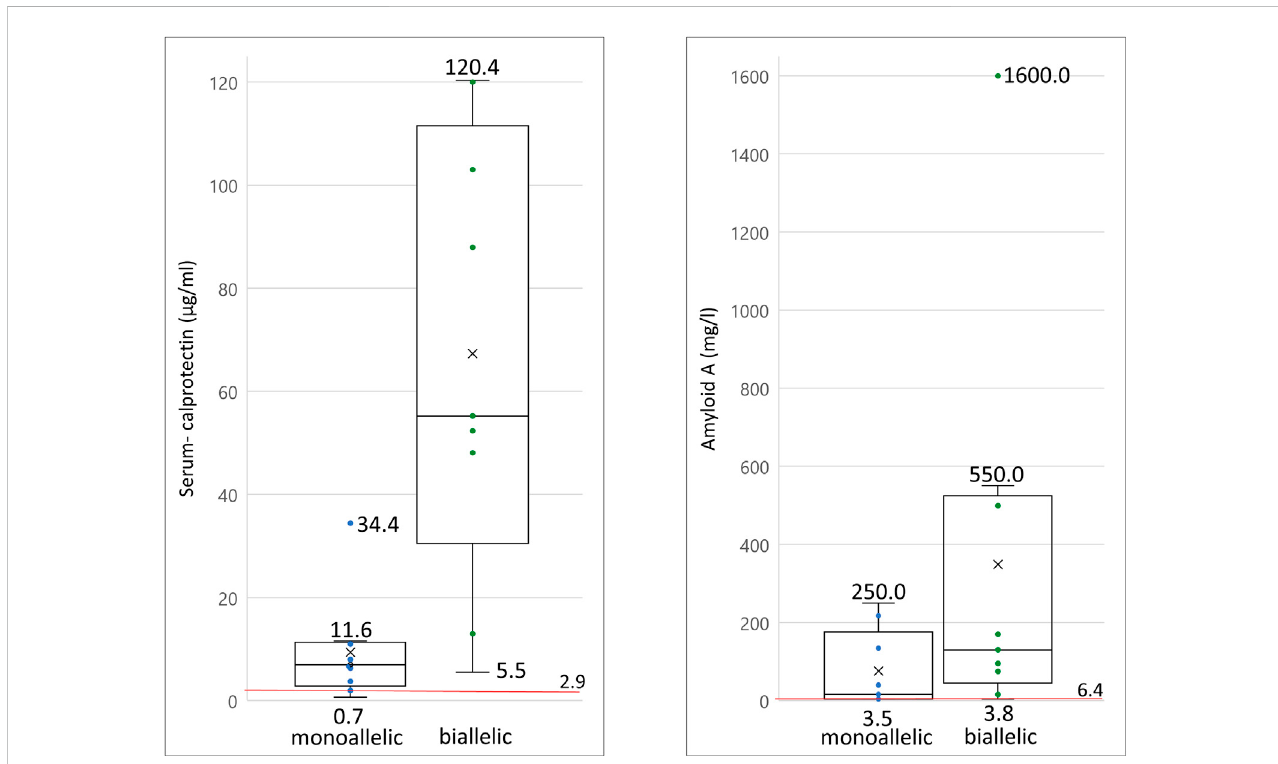
FIGURE 4 Serum levels of in fl ammatory biomarkers measured in patients with pathogenic MEFV variants a) serum calprotectin levels of monoallelic and biallelic carriers of pathogenic MEFV variants; b) serum amyloid A levels of monoallelic and biallelic carriers of pathogenic MEFV variant. Each dot and each horizontal extreme line corresponds to a value in one patient (n = 9); cross symbolizes the mean value of all patients; red line drawn at reference serum level cut-off point; the horizontal line in the middle of a box plot displays the